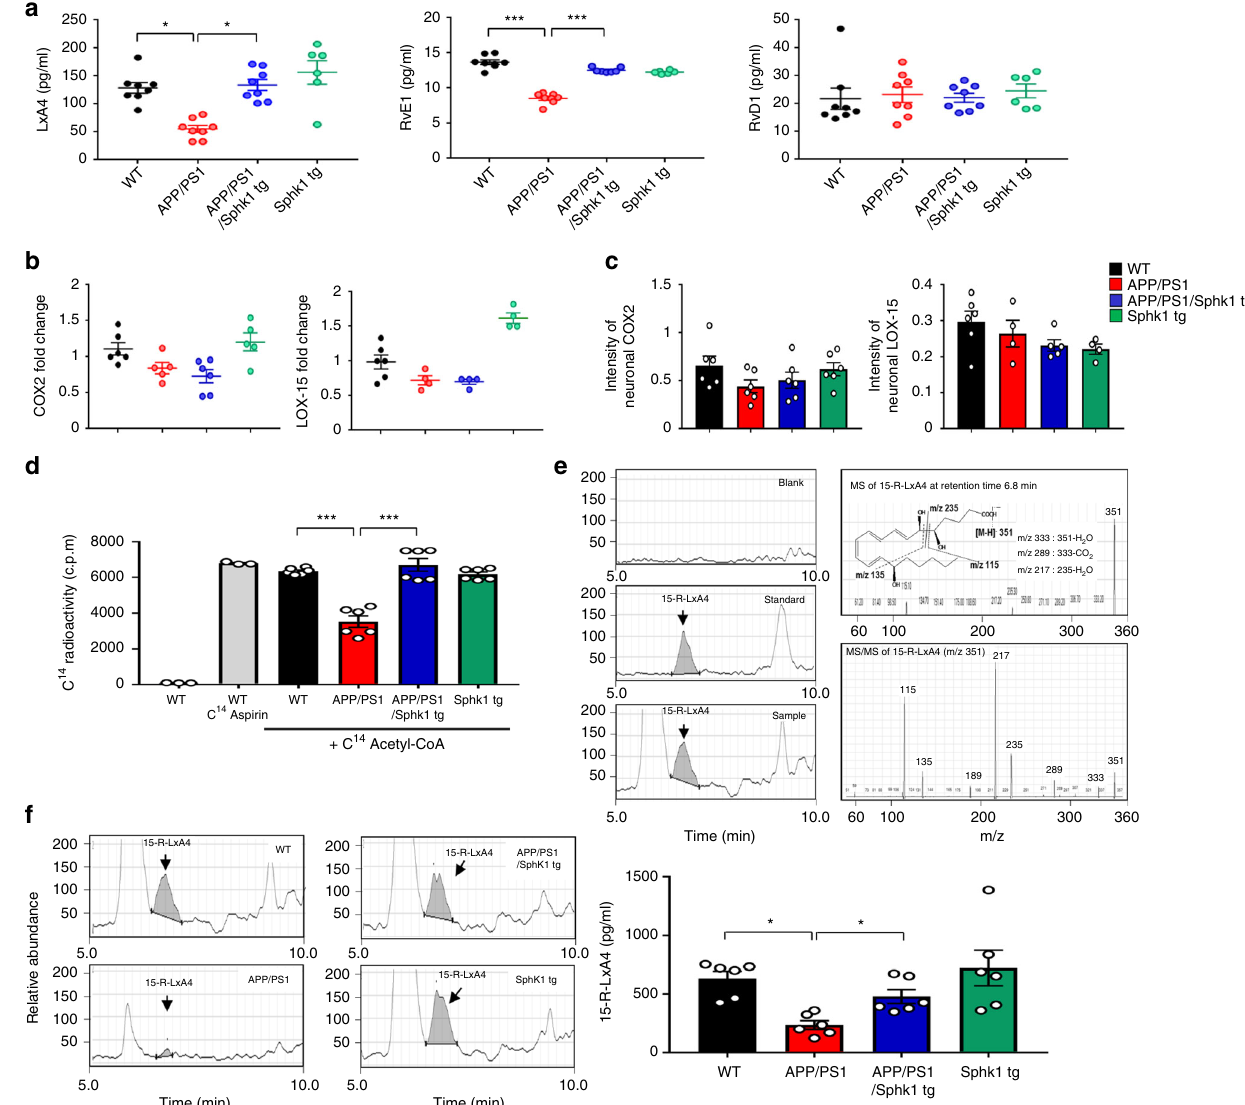
Fig. 3 Neuronal SphK1 induces SPMs secretion by COX2 acetylation. a Protein levels of LxA4, RvE1, and RvD1 were detected by using ELISA in CM of neurons derived from WT, APP/PS1, APP/PS1/SphK1 tg, and SphK1 tg mice ( n = 6 – 8 per group). b mRNA levels of COX2 and LOX-15 in neurons derived from cortex of WT, APP/PS1, APP/PS1/SphK1 tg, and SphK1 tg mice ( n = 4 – 6 per group). c Quanti fi cation of neuronal COX2 ( n = 6 per group) and neuronal LOX-15 ( n = 4 – 6 per group). d Acetylation assay of COX2 protein in neurons derived from WT, APP/PS1, APP/PS1/SphK1 tg, and SphK1 tg mice. [ 14 C] aspirin-treated neuron was positive control. Sonicated neurons incubated in the presence of [ 14 C] acetyl-CoA for 2 h at 37 °C and then COX2 was puri fi ed and analyzed on scintillation counter ( n = 3 – 6 per group). e Representative chromatograms of blank, 15-R-LxA4 standard, and 15-R-LxA4 in WT samples (left panel). Molecular MS scanning from the peak at retention time 6.8 min (right upper panel) and MS/MS fragmentation pattern of 15-R-LxA4 from the peak at retention time 6.8 min (right lower panel). f Representative chromatograms (left panel) and quanti fi cation of 15-R-LxA4 in neurons derived from WT, APP/PS1, APP/PS1/SphK1 tg, and SphK1 tg mice with acetyl-coA treatment (24 h after 2.5 mM acetyl-CoA treatment) (right panel, n = 6 per group). All data analysis was done on 9-month-old mice. a − d , f One-way analysis of variance, Tukey ’ s post hoc test. * P < 0.05, *** P < 0.001. All error bars indicate value of 6.8 μ M (Fig. 4b). The lower K D (i.e., dissociation con- stant) value compared with K M value (i.e., binding af fi nity) sug- gested the acetyltransferase characteristics of SphK1. The calculated turnover rate for SphK1 ( K cat = 0.0185 min -1 ) is quite low in comparison to those of known nuclear acetyltransferases.